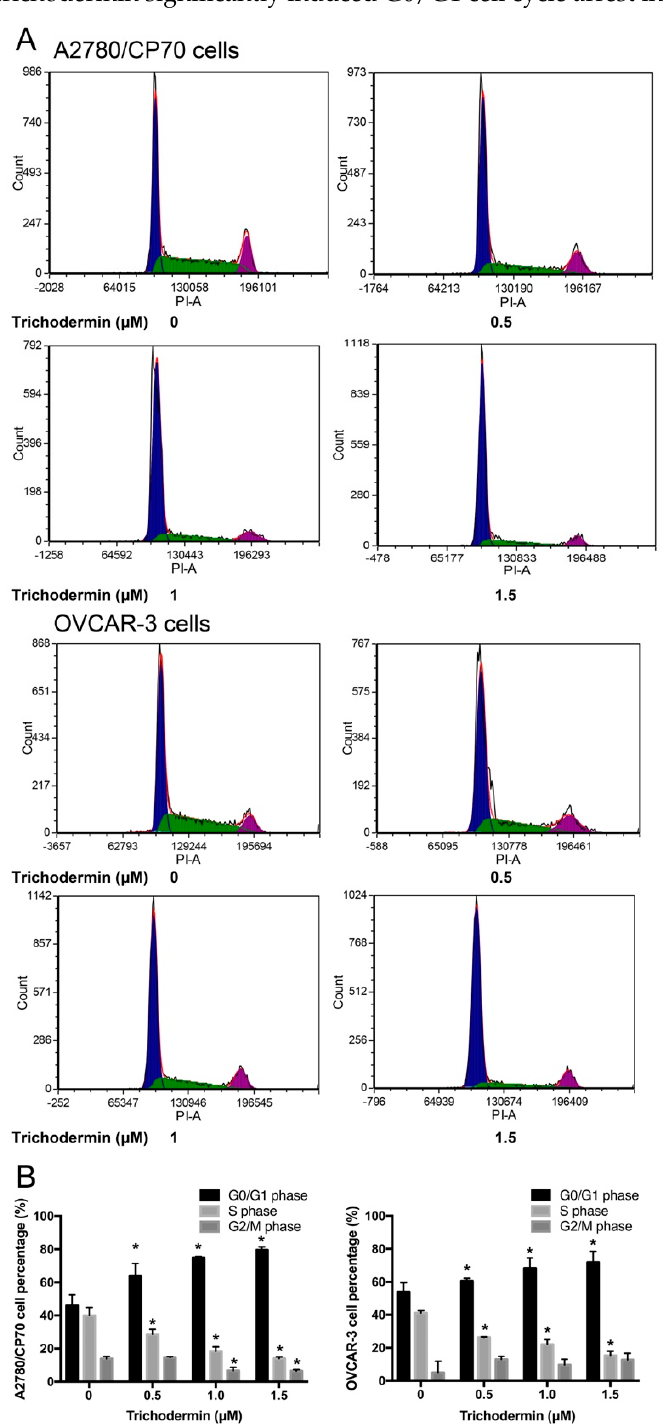
Figure 2. Trichodermin induced G0/G1 cell cycle arrest in A2780/CP70 and OVCAR-3 cells after 24 h treatment. The cell distribution was measured using flow cytometry. ( A ) Flow cytometry plots. ( B ) The cell cycle distribution of A2780/CP70 cells and OVCAR-3 cells after trichodermin treatment. * p < 0.05 compared with the control group.